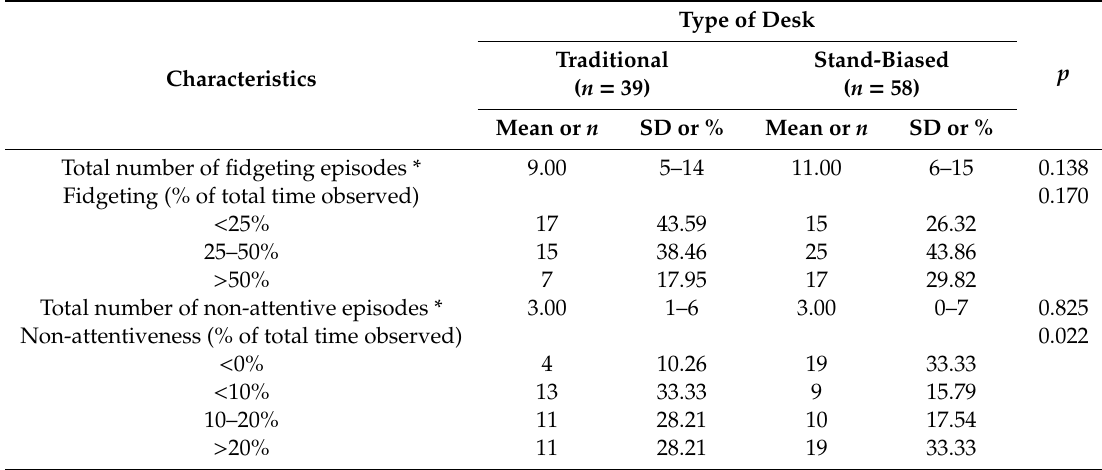
Table 3. Fidgeting and non-attentive episodes at